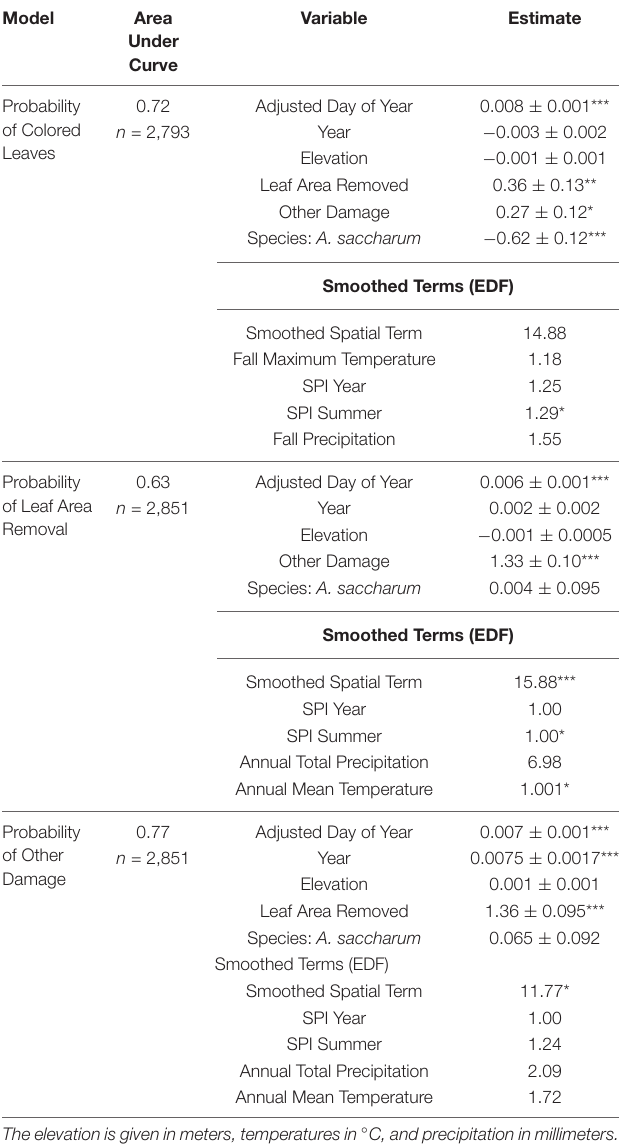
TABLE 2 | Results of a logistic regression relating environmental variables to whether a specimen had colored leaves, leaf area removal, or other damage. Parameter estimates are reported ± standard error, along with variance inflation factors (VIF).